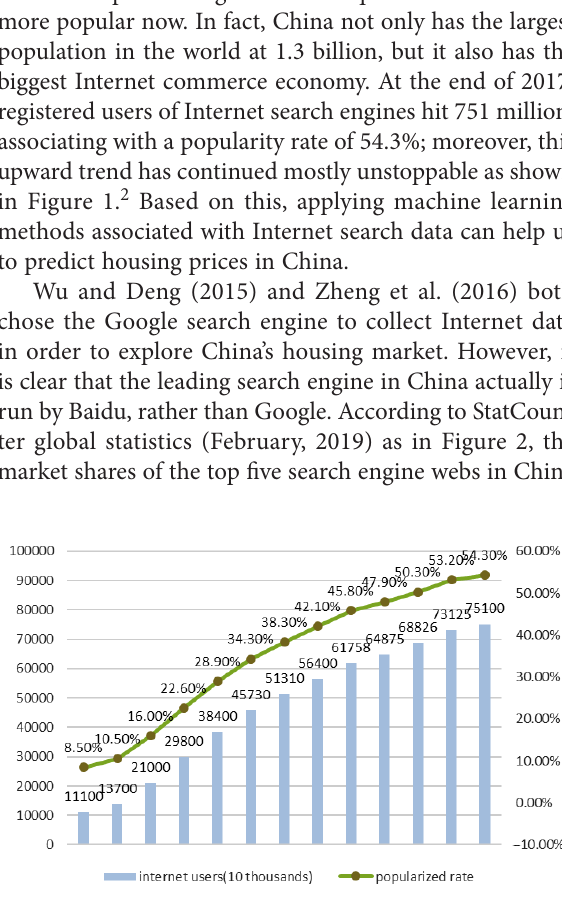
1. Internet popularity trend in China (2005–2017)